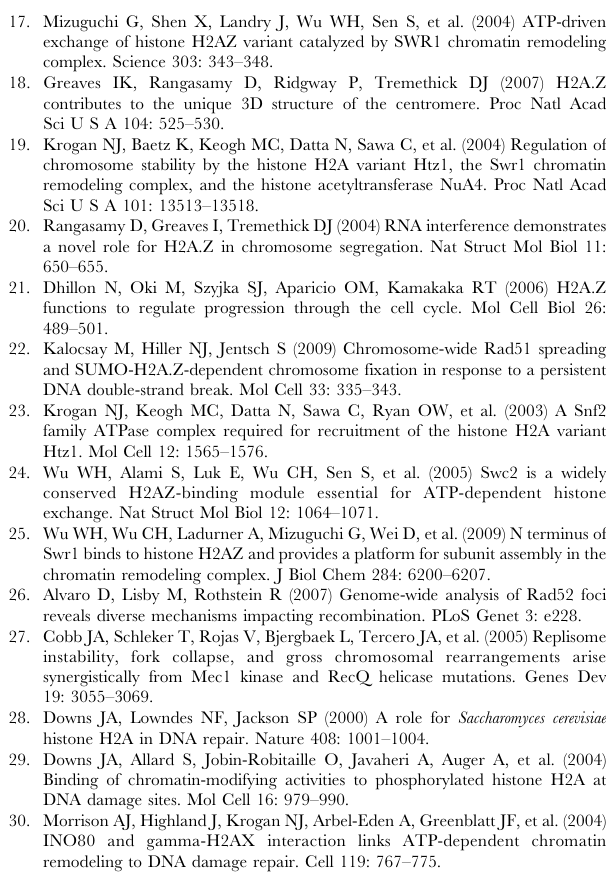
Table S4 for oligos). The enrichment is graphed relative to the enrichment in the wild-type strain incubated with IgG, taken as 1. ChIP experiments were performed in BY4741 background. Figure S5 Analysis of spontaneous DNA breaks as determined by PFGE of yeast chromosomes in htz1 D , swr1 D , htz1 D swr1 D and wild type.